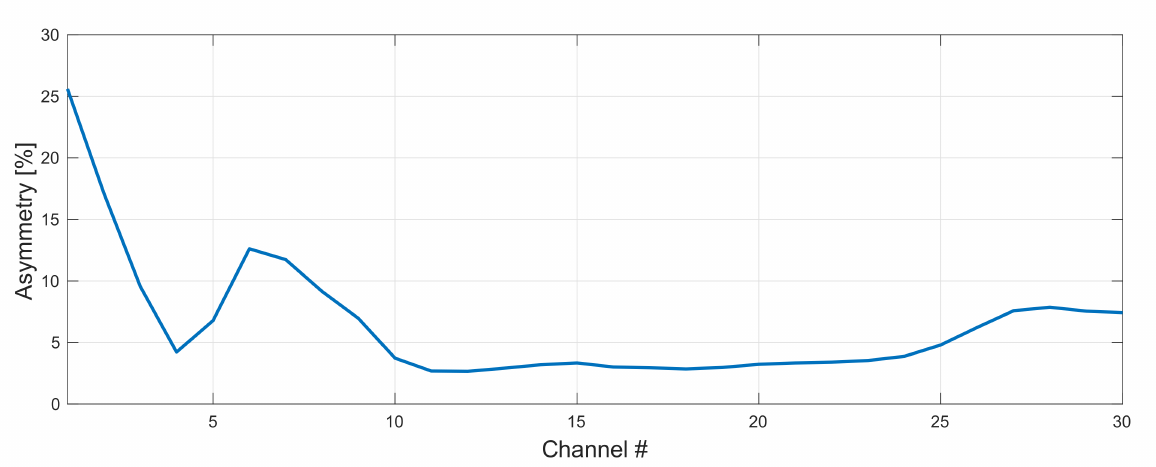
Figure 6. WDM grid with the best average asymmetry of 6.4%. Forward pump power was set to be 1 W and 1.3 W and FBG to 1462 nm and 1446 nm for original and conjugated WDM grid,